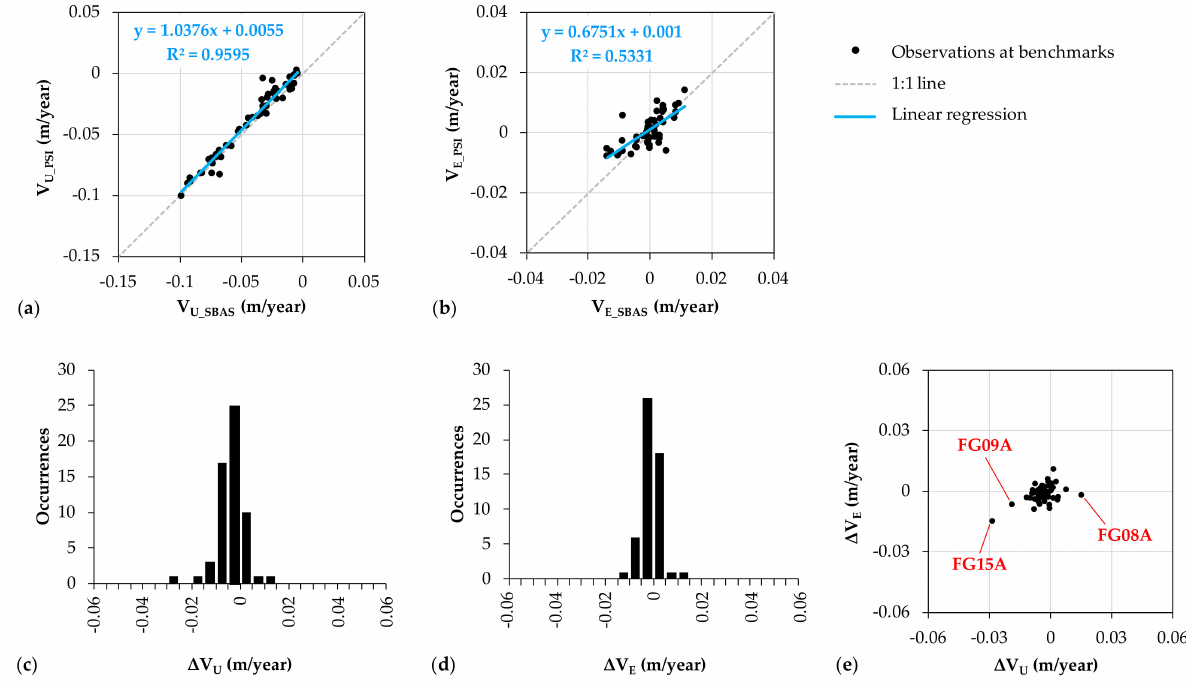
Figure 10. Comparison of the displacement velocity along the ( a ) vertical V U and ( b ) east-west V E direction as estimated from the SBAS and PSI InSAR analyses at the 2 permanent GNSS stations and 62 GNSS benchmarks, and distribution of their observed differences: ( c ) ∆ V U and ( d ) ∆ V E , respectively. The latter are also inter-compared in ( e